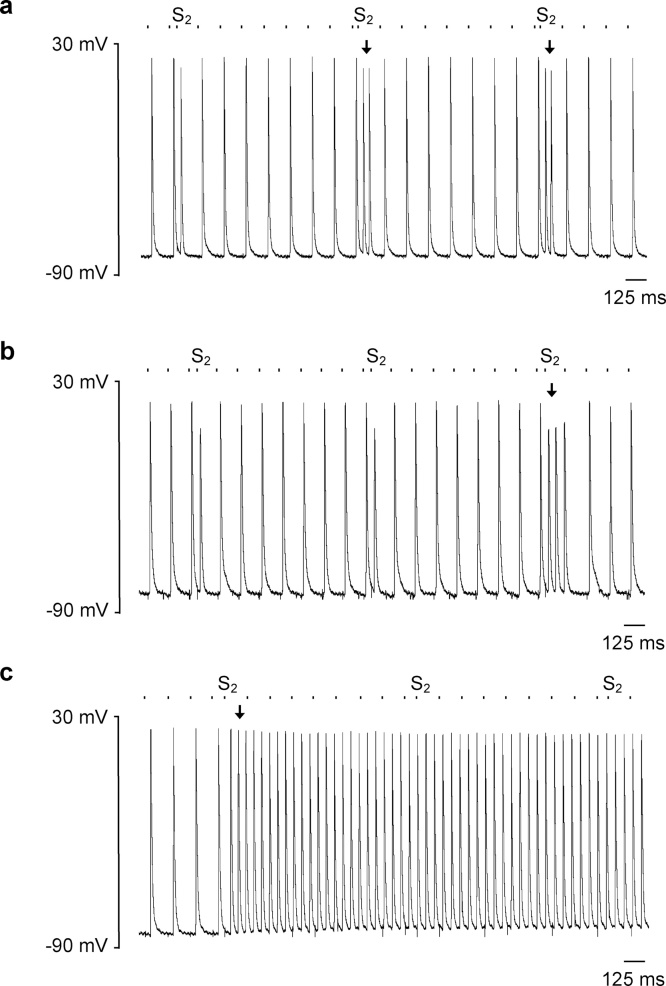
Examples of intracellular records of abnormal rhythms elicited by S2 premature stimuli during PES pacing, including (a) isolated ectopic beats, (b) paired beats forming couplets and (c) episodes of atrial tachycardia (AT) defined as three or more consecutive non-stimulated beats. The timings of stimulus delivery are given by the dashed bar above the AP recordings and arrows indicate the onset of the abnormal rhythm.